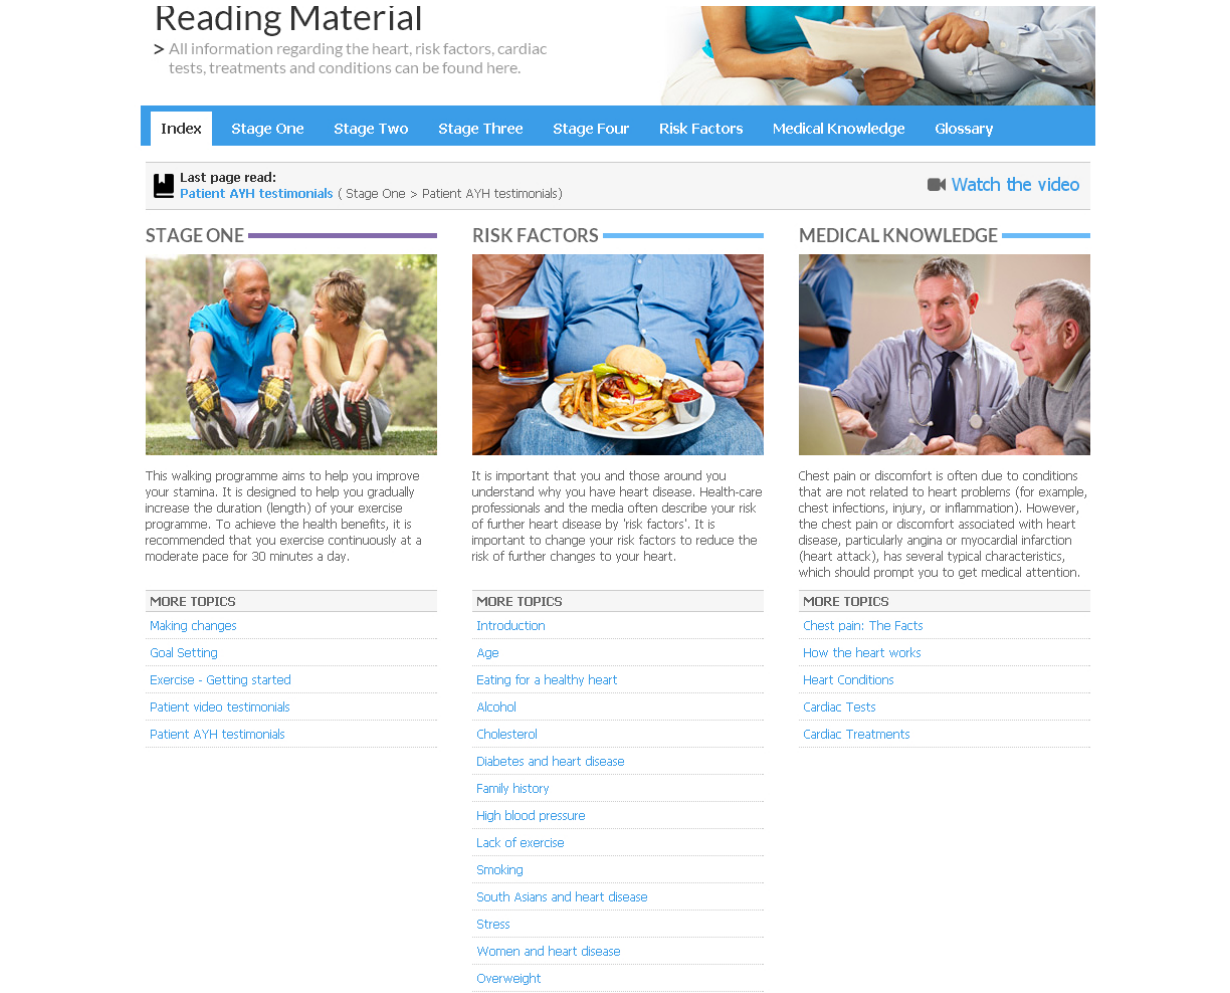
Figure 2. Reading material